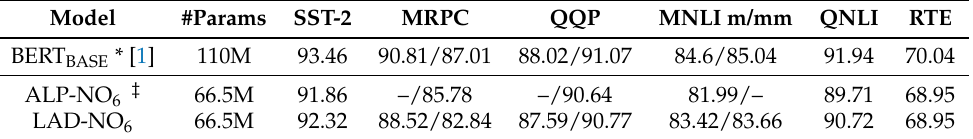
Table 4. Performance comparisons between LAD-NO and ALP-NO [15] on GLUE development sets. The value in parentheses represents the difference in performance between the student model and its corresponding teacher model.